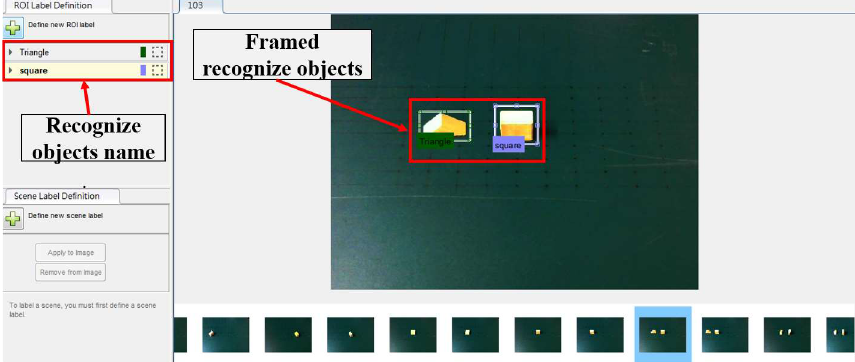
Figure 9. Marking objects.